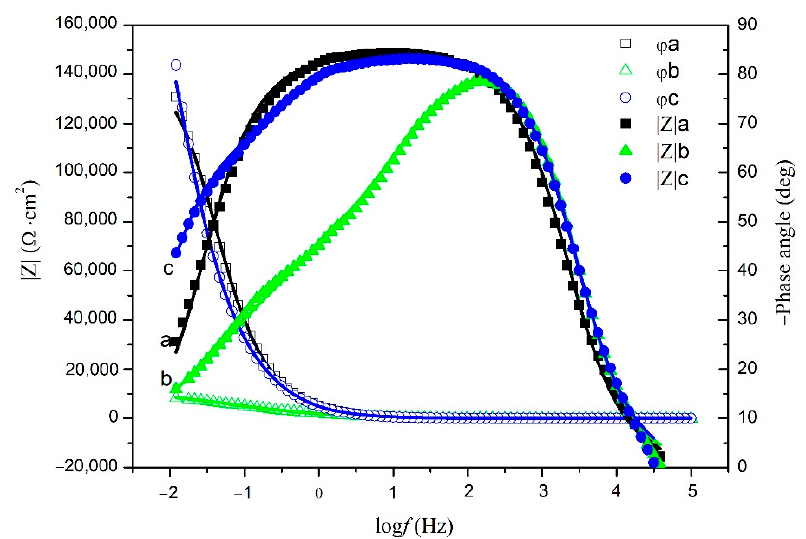
Figure 13. Bode plots of the carbon steel without cathodic protection (a: 0 day; b: 21 days) and with cathodic protection (c: 21 days) immersed in NSCS.